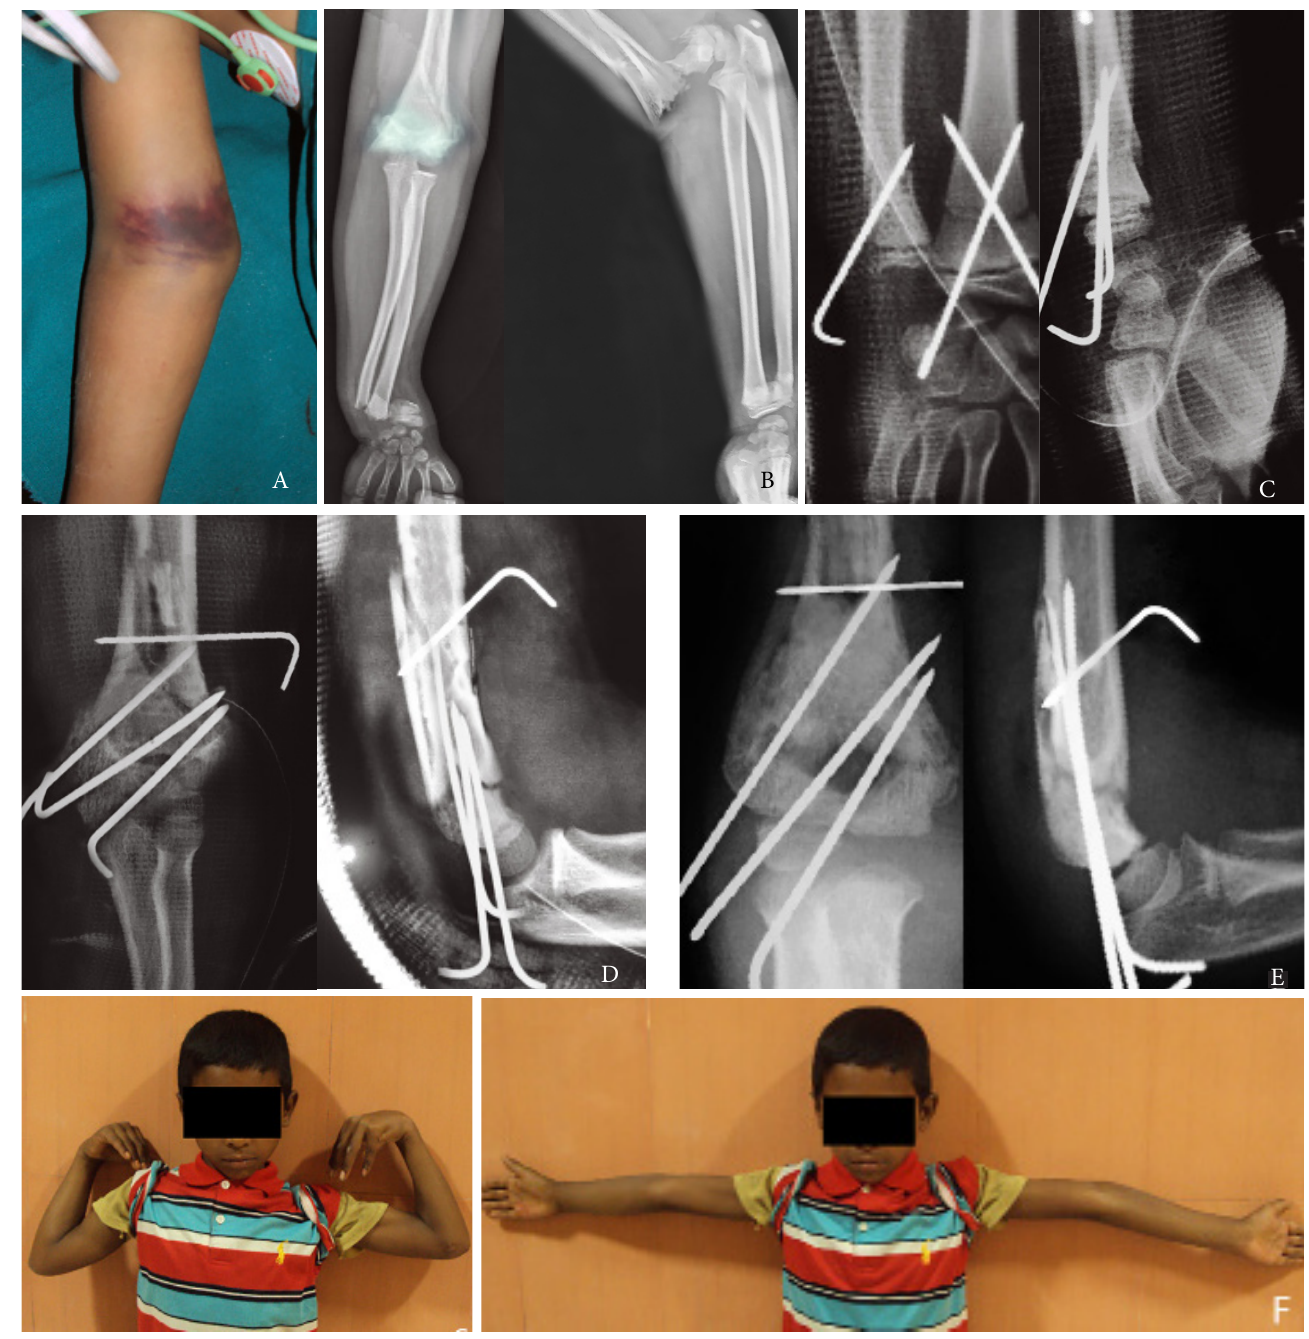
Fig 1 : ( A ) Clinical photograph of injured limb; ( B ) AP and latearal plain radiographs notable for type III supracondylar humerus fracture and ipsilateral distal shaft fracture with dorsally displaced distal radius and ulna; ( C ) Postoperative posteroanterior and lateral radiographs show stable fixation of the distal radius with cross k wires; ( D )Similarly, elbow raiographs show stable anatomical fixation of the distal humerus with three lateral Kirschner wires; ( E ) Six weeks postoperative elbow radiographs with abundant callus formation and interval healing of the all the fractures fracture; ( F ) Four months clinic visit with a good elbow function (note cubitus